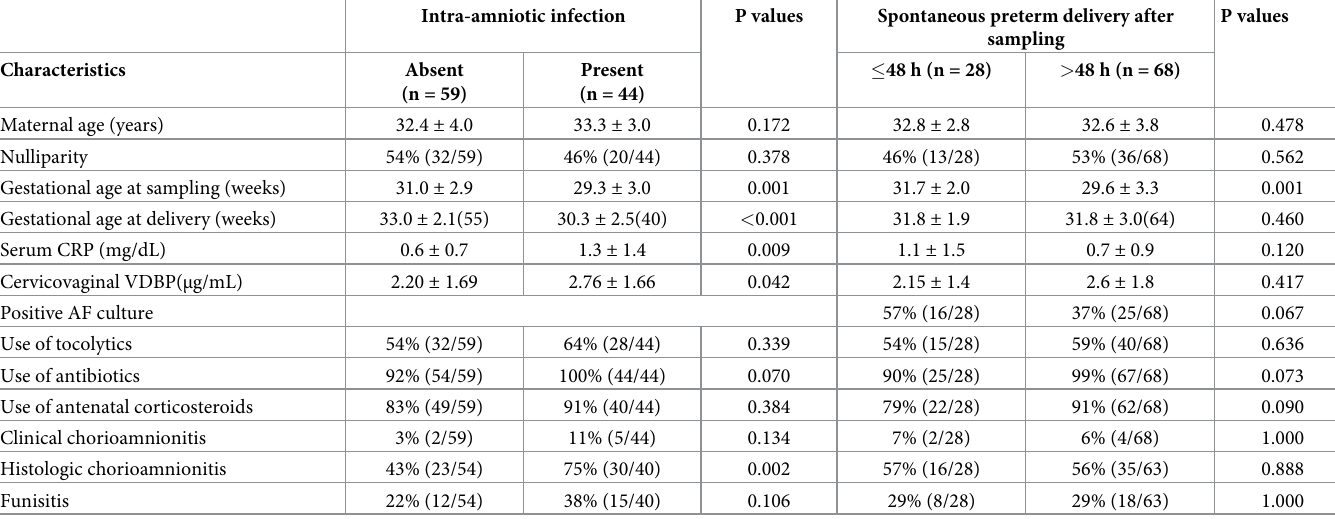
Table 3. Clinical characteristics of the study population according to the results of the amniotic fluid culture and occurrence of delivery within 48 hours of sampling in women with preterm premature rupture of